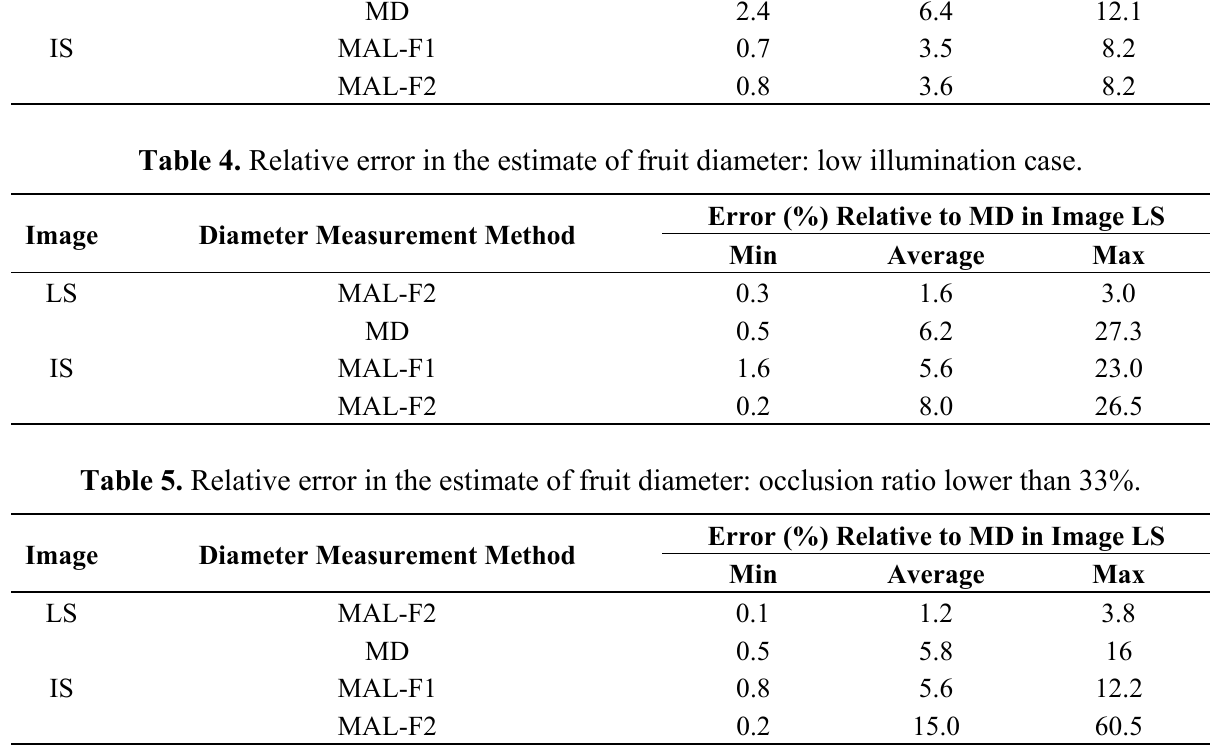
Table 6. Relative error in the estimate of fruit diameter: occlusion ratio from 33% to 66%. Image